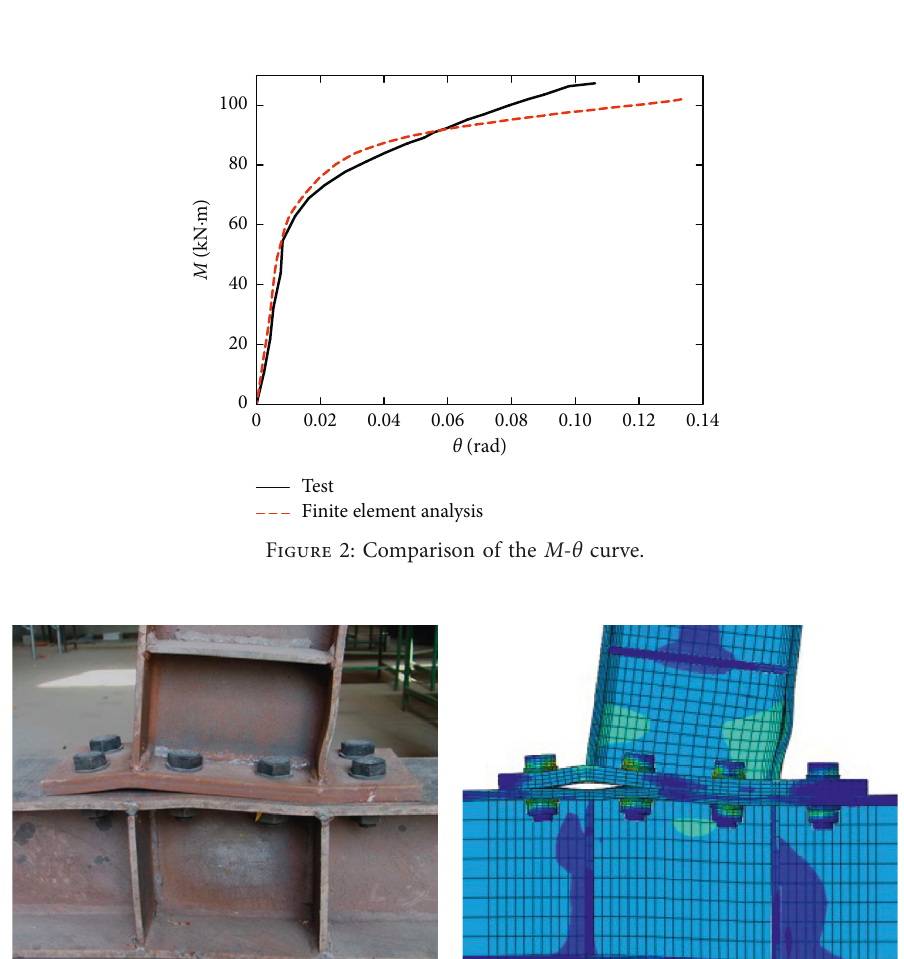
Figure 1: Test setup. (a) Design setup. (b) Practical setup.